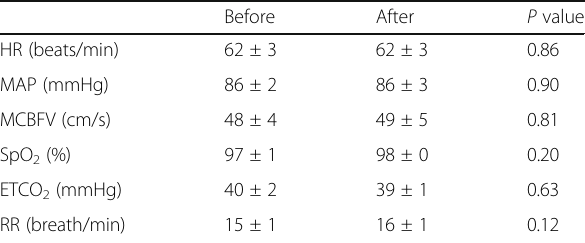
Table 1 Steady-state hemodynamic and respiratory